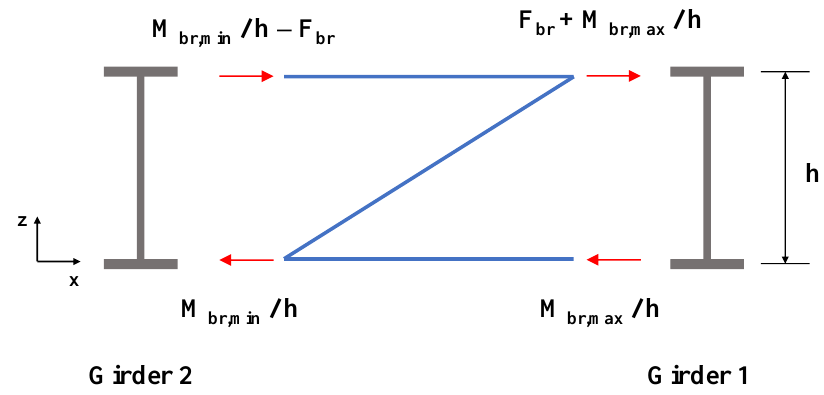
Figure 5. Bracing moments and internal forces acting on bracing members.